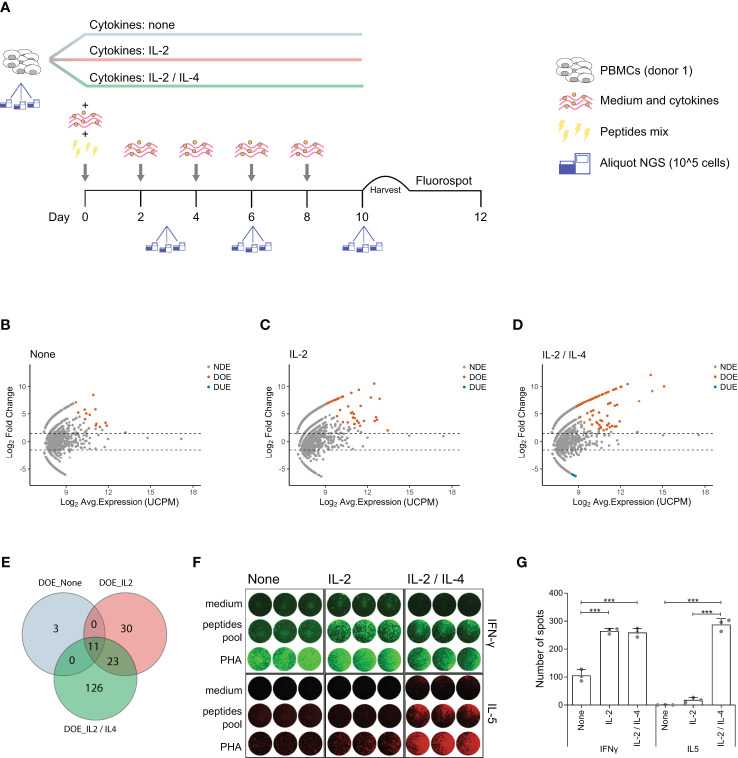
IL-4 induces expansion of antigen-responsive, IL-5 producing TCR clones with unique TCRs. (A) Schematic representation of the in vitro culture system modified to include different T cell skewing cytokines. PBMCs are equally divided in three fractions and then cultured separately in three different cytokines milieus: no cytokines, only IL-2 or IL-2 and IL-4 combined. All the other culture conditions are the same as described in Figure 1. At day 10 PBMCs are harvested and plated for the FluoroSpot assay. Aliquots for TCR analysis are taken at day 0 (before stimulation), day 3, day 6, and day 10 post-stimulation. (B–D) MA plots showing the differential expansion of individual TCR clones between the day 0 and day 10 repertoire in in vitro cultures after antigen stimulation in presence of (B) no cytokines, (C) IL-2 only or (D) both IL-2 and IL-4. Each dot represents an individual TCR clone where the x- and y-axes depict the average log2 clonal frequency (calculated from UMI counts per million; UCPM) and log2 fold change compared to day 0 respectively. Differentially (Benjamini–Hochberg corrected p-value <0.05) Over-Expanded clones (DOE; fold changes > 1.5) are colored in orange, Differentially Under-Expanded clones (DUE; fold changes < −1.5) are colored in blue, while Not Differentially Expanded clones (NDE, −1.5< fold changes < 1.5) are colored in gray. (E) Venn diagram showing the overlap of clones selected as Differentially Over-Expanded (DOE) in the day 10 repertoire of in vitro stimulated cultures in presence of no cytokines (light blue circle), IL-2 only (rose circle) or IL-2 and IL-4 (green circle). (F) Results of the FluoroSpot assay for the detection of T cells that produce interferon-γ (IFN-γ) (FITC filter, top panel) and interleukin-5 (IL-5) (Cy5 filter, bottom panel) re-stimulated after 10 days of growth in different cytokine milieus with PHA, a pool of antigenic peptides or medium. (G) Histograms depicting the mean (±SD) number of T cell spots producing IFN-γ (left panel) or IL-5 (right panel) from the FluoroSpot assay performed at the end of the in vitro culture in the presence of no cytokine, IL-2 only or both IL-2 and IL-4 from a single healthy donor (***p ≤ 0.001 using one-way ANOVA followed by Bonferroni’s Multiple comparison post-test).